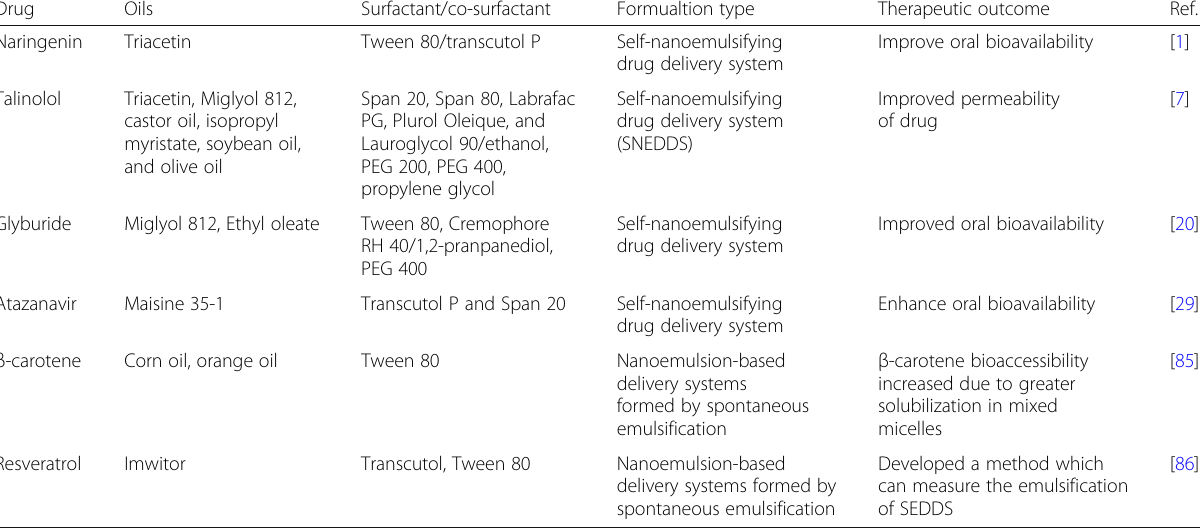
Table 4 List of drugs formulated as solid/liquid self-nano emulsified drug delivery systems (SNEDDS) Drug